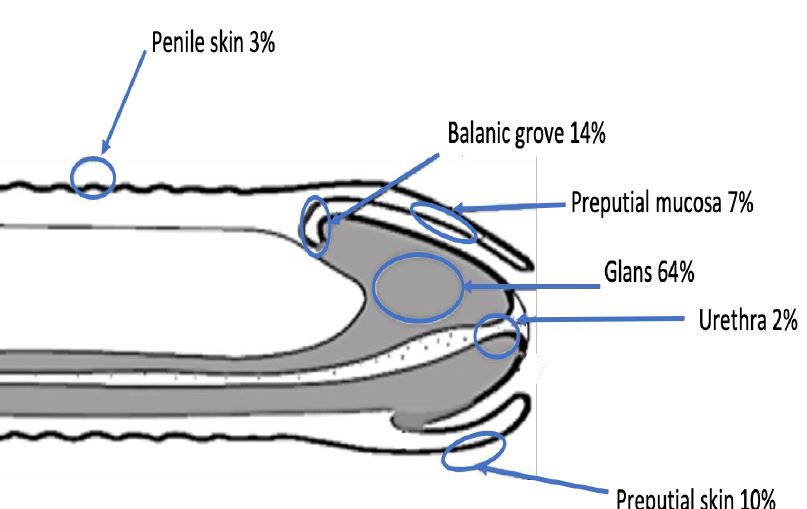
Figure 2. Localization of penile cancer lesions.